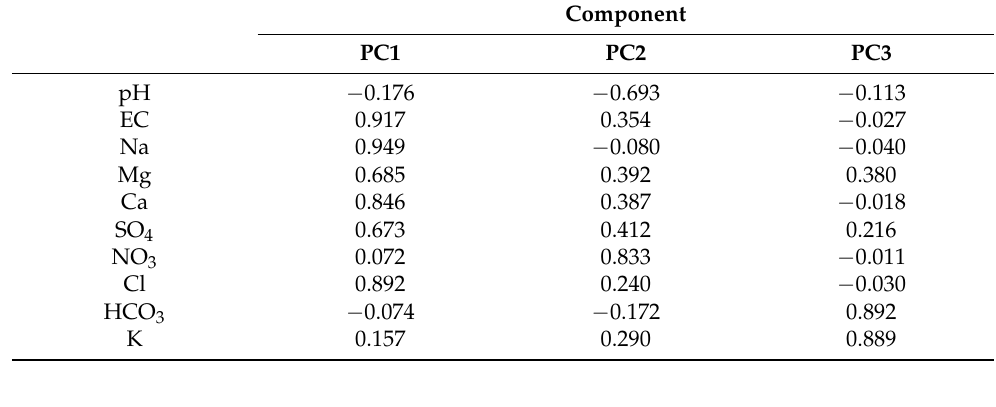
Table 2. Component matrix using principal component analysis as an extraction method.